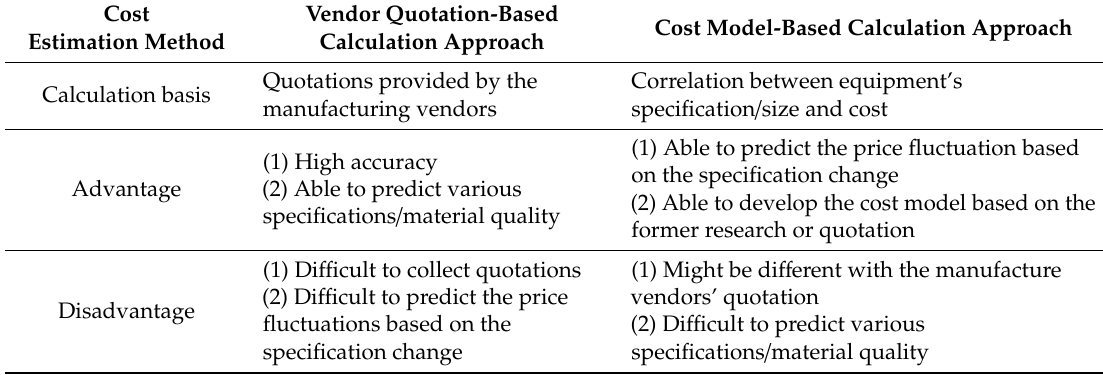
Table 1. Comparisons of equipment cost estimation methods.